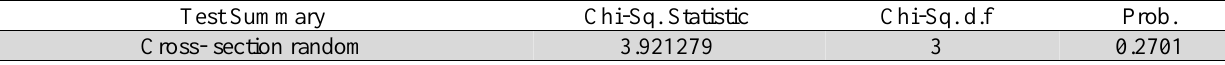
Correlated Random Effects- Hausman Test of Hypothesis 1